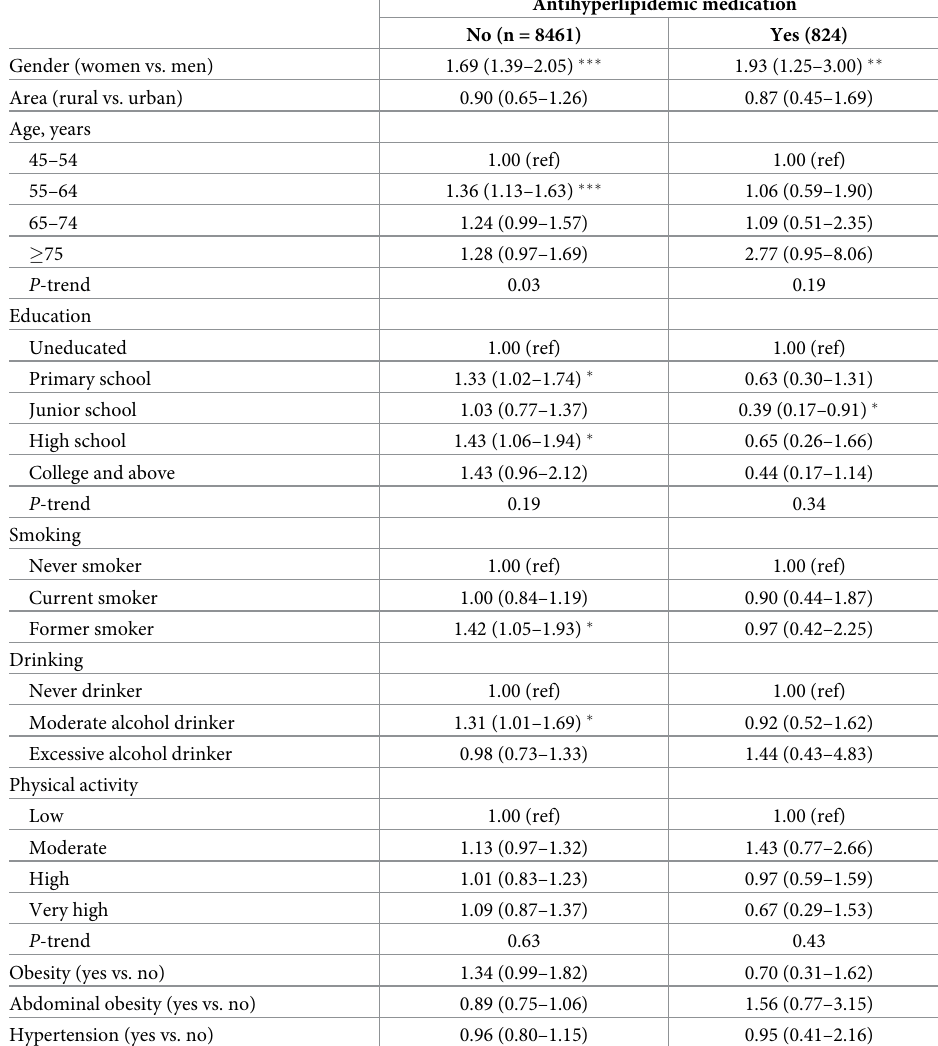
Table 4. The associated factors of high LDL-C among T2DM